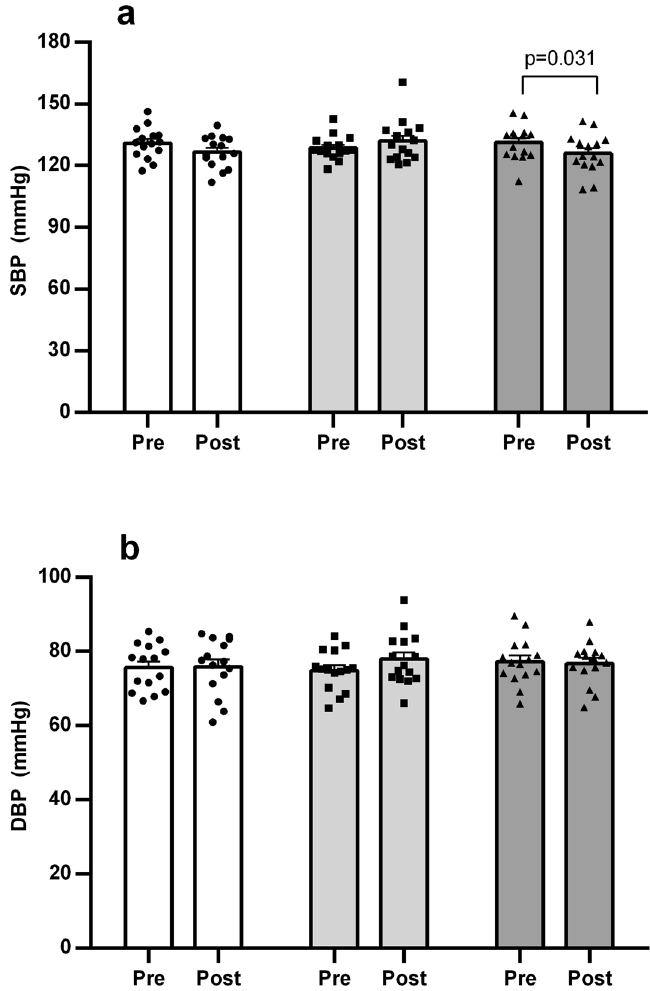
Figure 2. Brachial systolic blood pressure ( a ) and diastolic blood pressure ( b ) before and after aerobic exercise (white bars), resistance exercise (light grey bars), and concurrent exercise (dark grey bars). Data expressed as mean ±